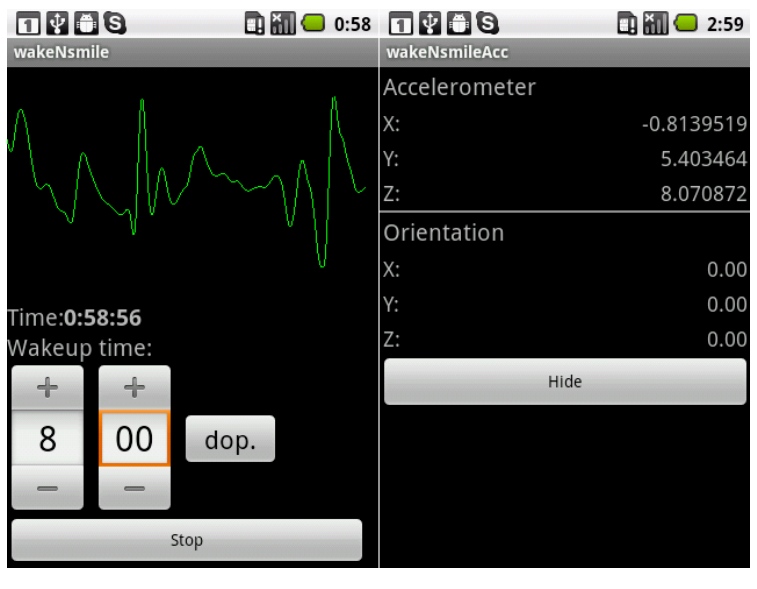
Figure 13. wakeNsmile and wakeNsmileAcc application on the Android